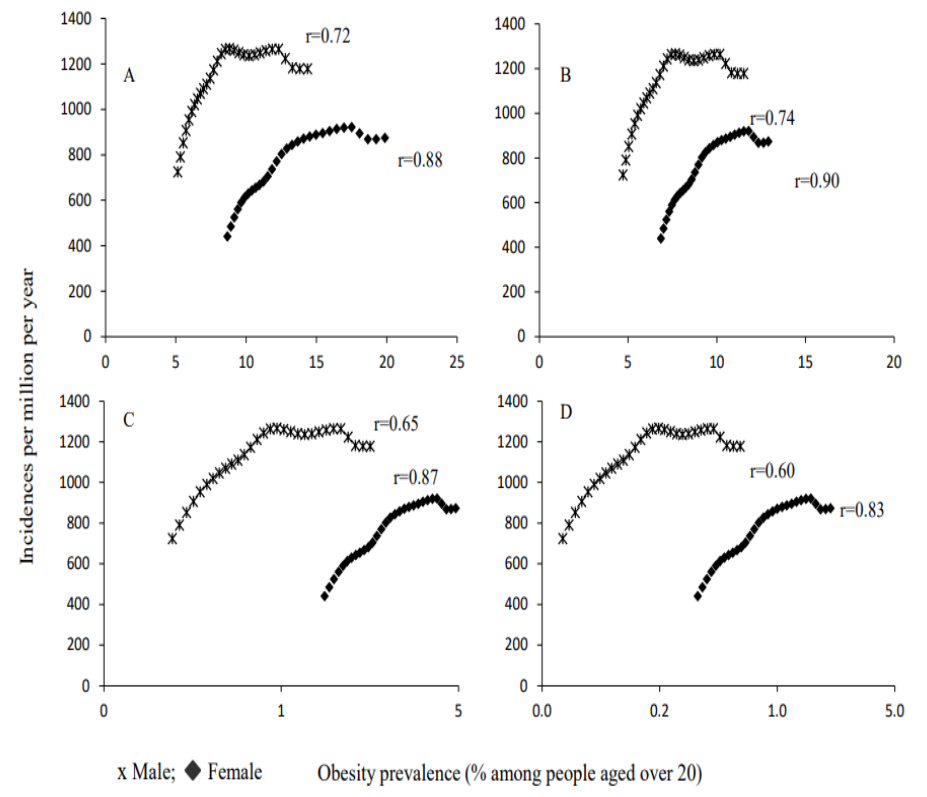
Figure 3. Ecological relationships between incidence rates of ischemic heart disease and obesity prevalence. ( A ) Obesity (BMI > 30); ( B ) Class I (BMI = 30 – 34.9); ( C ) Class II (BMI = 35 – 39.9); ( D ) Class III (BMI ≥ 40).